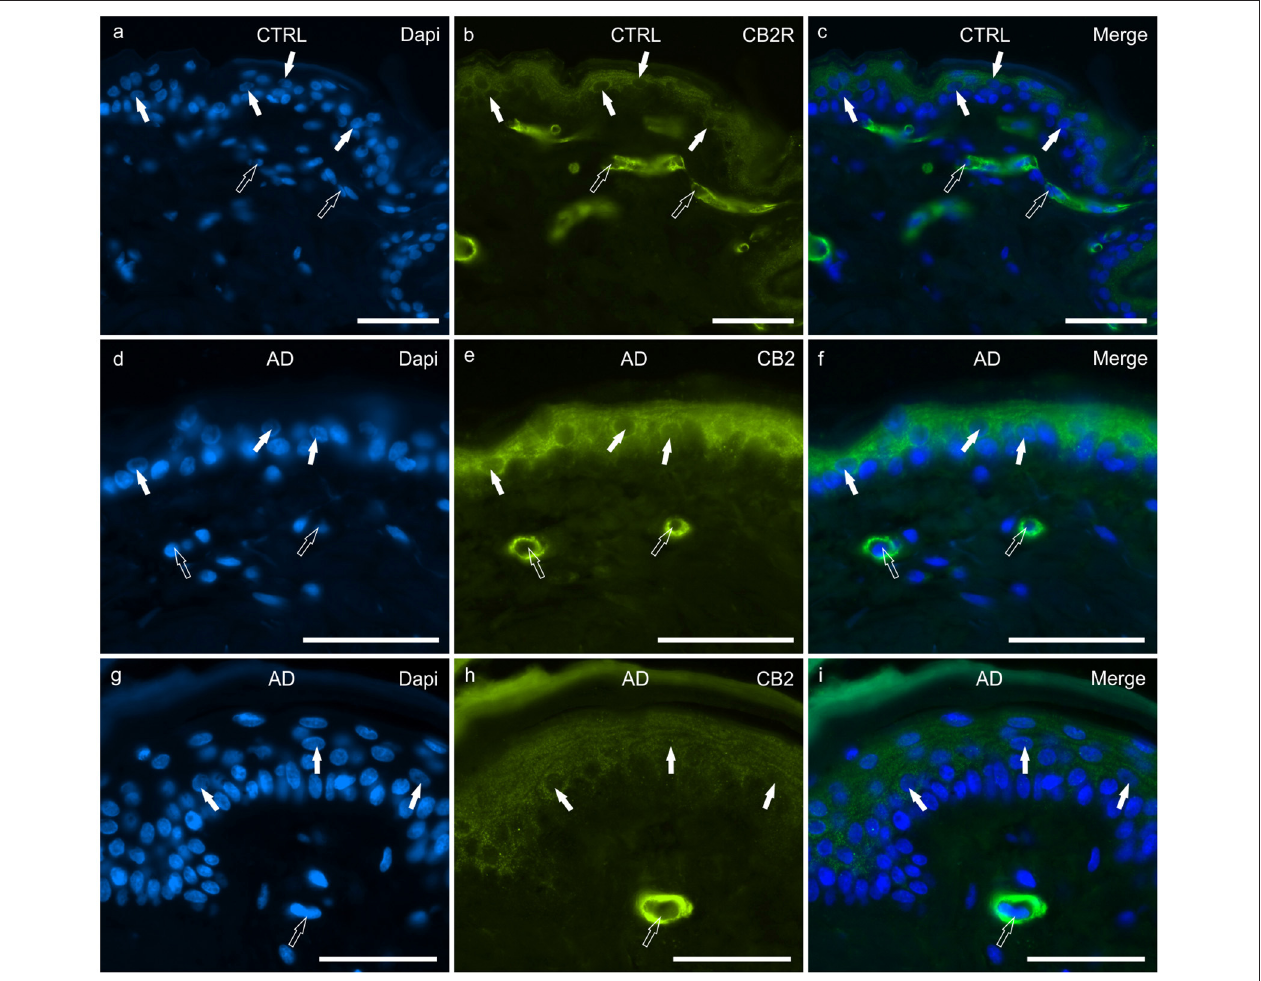
FIGURE 2 | Photomicrographs of cryosections of canine skin showing cannabinoid receptor 2 (CB2R) immunoreactivity (IR) in the tissues of the healthy dogs (CTRL) (a–c) and in the dogs with atopic dermatitis (AD) (d–i) . (a–c) The white arrows indicate the DAPI-labeled nuclei of the keratinocytes showing moderate CB2R-IR of the cytoplasm and cell membrane. The open arrows indicate the DAPI-labeled nuclei of vascular endothelial cells of the dermis showing bright CB2R-IR. (d–i) The white arrows indicate the DAPI-labeled nuclei of the keratinocytes of the dogs with AD showing bright CB2R-IR. The open arrows indicate the DAPI-labeled nuclei of the vascular endothelial cells of the dermis showing bright CB2R-IR. Bar, 50 µ